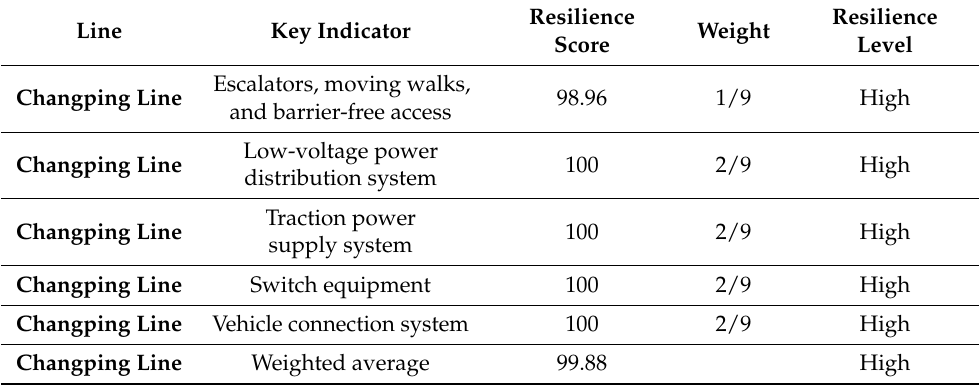
Table 9. Resilience assessment of the Changping Line under a new rainstorm event (22 August 2022). Line Key